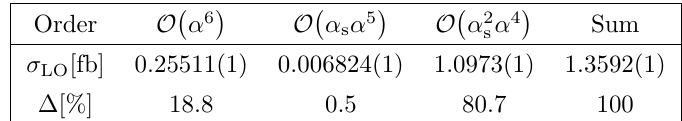
Table 1. LO cross sections (cid:27) LO (sum) and individual orders pp (cid:22) + (cid:22) (cid:0) e + (cid:23) e jj + X at the LHC with CM energy 13 TeV. Photon-induced contributions and ! as fraction (cid:1) relative to the sum of the three contributions (in percent). The digits in parentheses indicate the integration